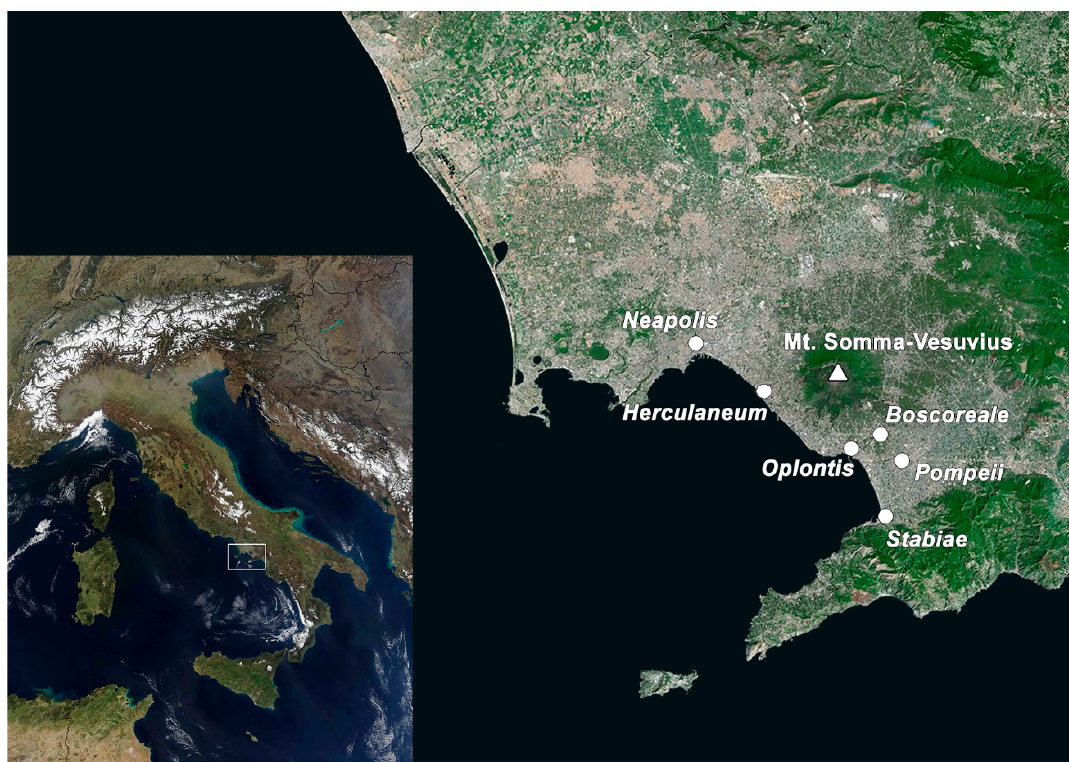
Figure 1. Map showing, with their Latin names, the main cities and towns affected by the eruption of Mount Somma–Vesuvius in 79 CE. Mount Somma–Vesuvius in 79